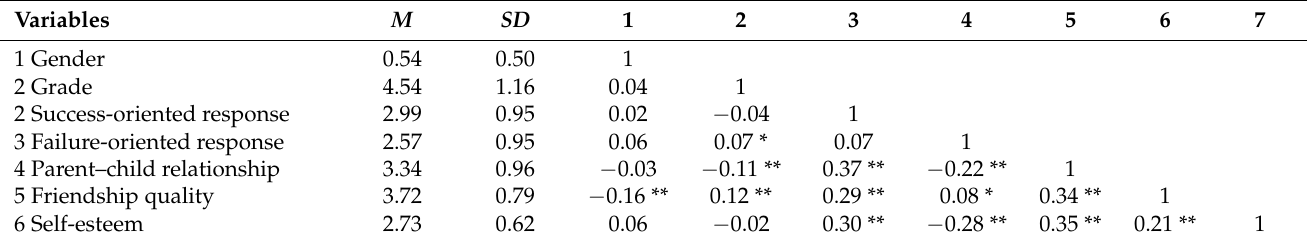
Table 1. Means, standard deviations, and correlation matrix ( N =